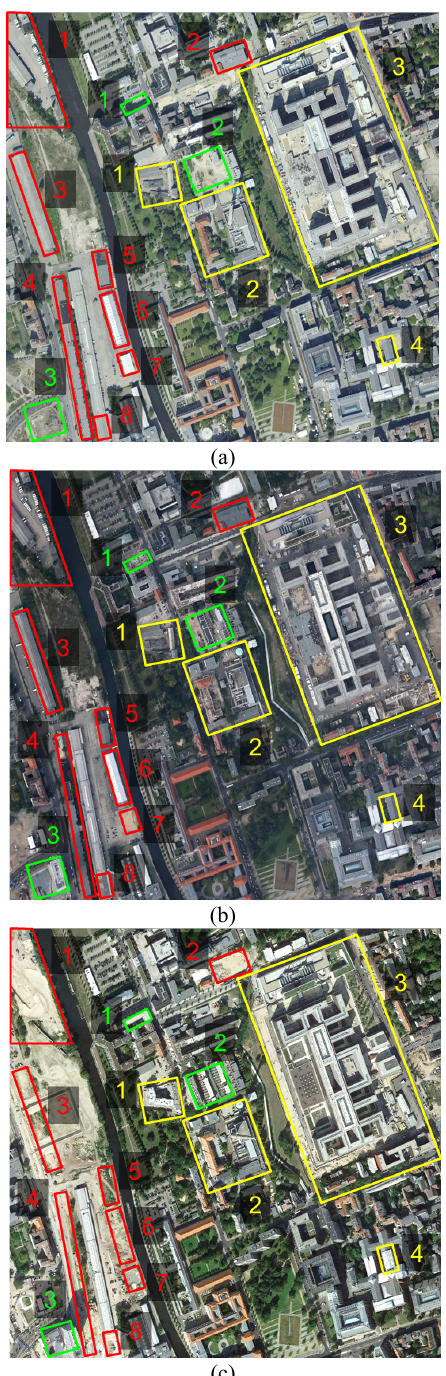
Figure 4. GE images around north of Berlin main station acquired on (a) 2010/09/12, (b) 2012/05/20, and (c) 2014/09/05. Building change: Red, demolition area; Green, erection area; Yellow, hybrid